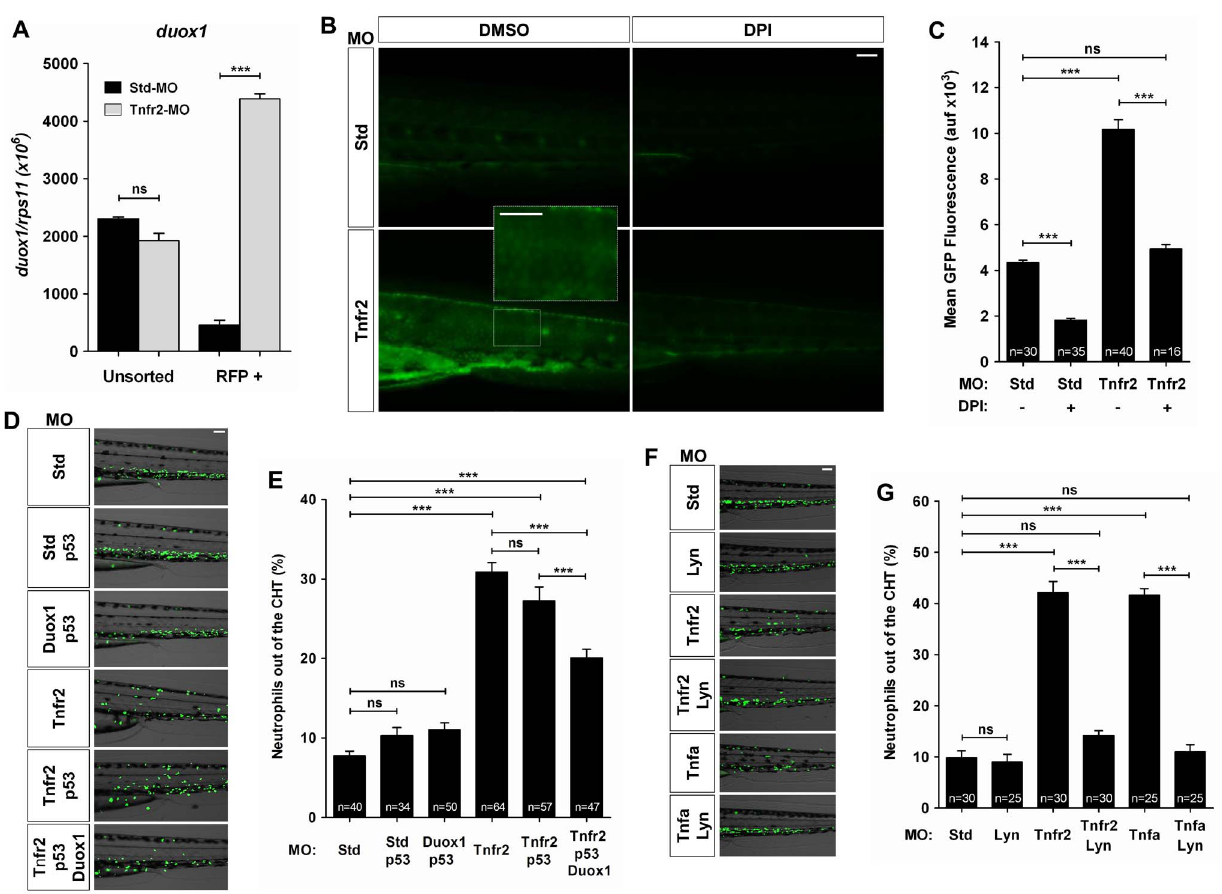
Figure 5. Tnfa and Tnfr2 deficiencies result in the Duox1-derived H 2 O 2 production by keratinocytes. Zebrafish one-cell krt18:RFP (A), wild-type (B, C), or mpx:eGFP (D–G) embryos were injected with standard control (Std), Tnfr2, Tnfa, Duox1/p53, and/or Lyn MOs. (A) The expression of the duox1 gene was measured by RT-qPCR in FACS-sorted keratinocytes from 72 hpf wild-type and Tnfr2-deficient larvae. (B, C) Wild-type and Tnfr2- deficient larvae were dechorionated at 24 hpf and treated by immersion in 100 m M DPI or vehicle alone (DMSO) for 24 h and then labeled with 50 m M acetyl-pentafluorobenzene sulphonyl fluorescein. Representative images of green channels of Std and Tnfr2 morphants are shown. Note that single keratinocytes are labeled with the H 2 O 2 probe in Tnfr2-deficient larvae (inset). (D–G) Rescues with Duox1 (D, E) and Lyn (F, G) MOs at 72 hpf. The differences in the neutrophil distribution (D, F) and quantification of neutrophil mobilization from the CHT to the skin in the indicated number of larvae per group from three different experiments (E, G) are shown. The mean 6 S.E.M. for each group is shown. Scale bars, 100 m m. ns, not significant. *** p , 0.001.